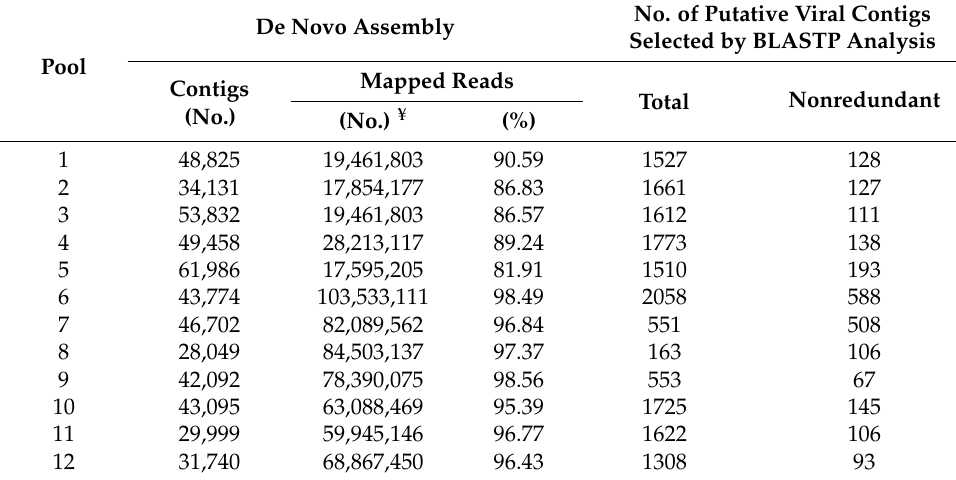
Table 3. Summary of the de novo assembly and BLASTP search of contigs.